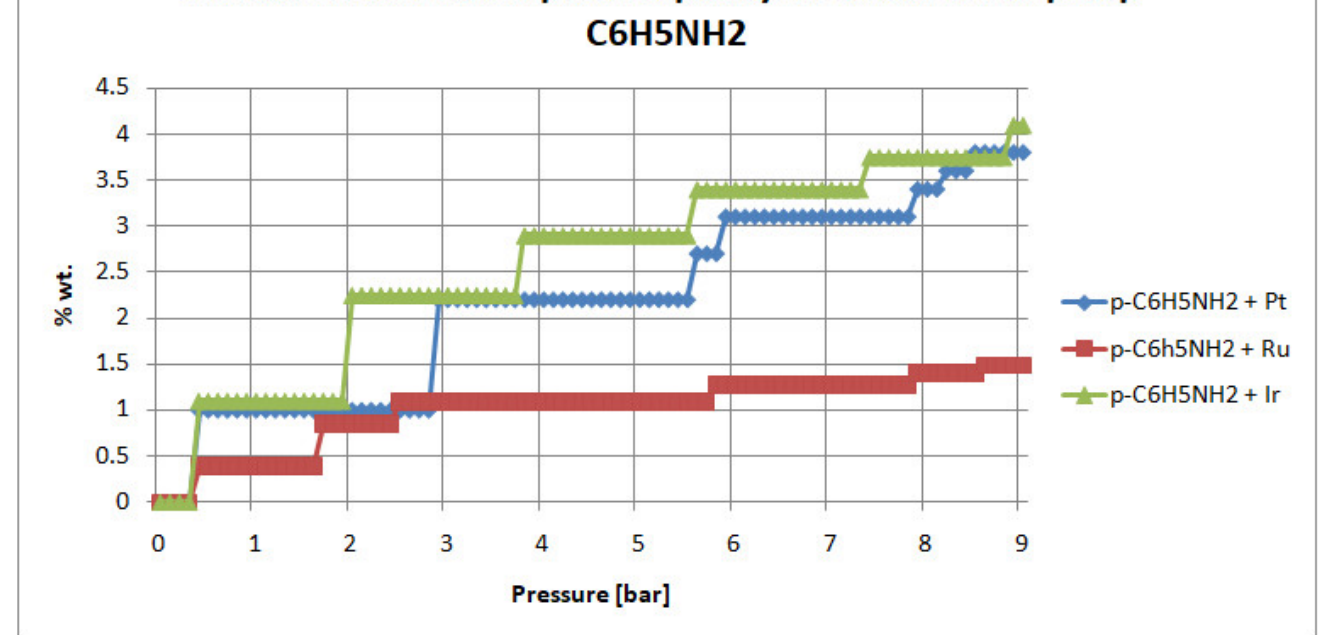
Figure 8. Metal-doped p-C 6 H 5 NH 2 H 2 -adsorption-capacity determination at 10 bar.